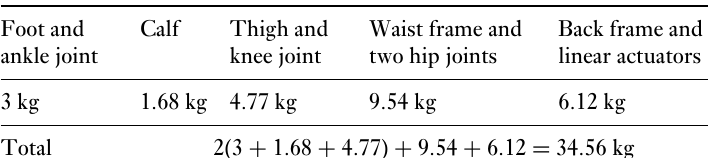
Table 2 Mass of the